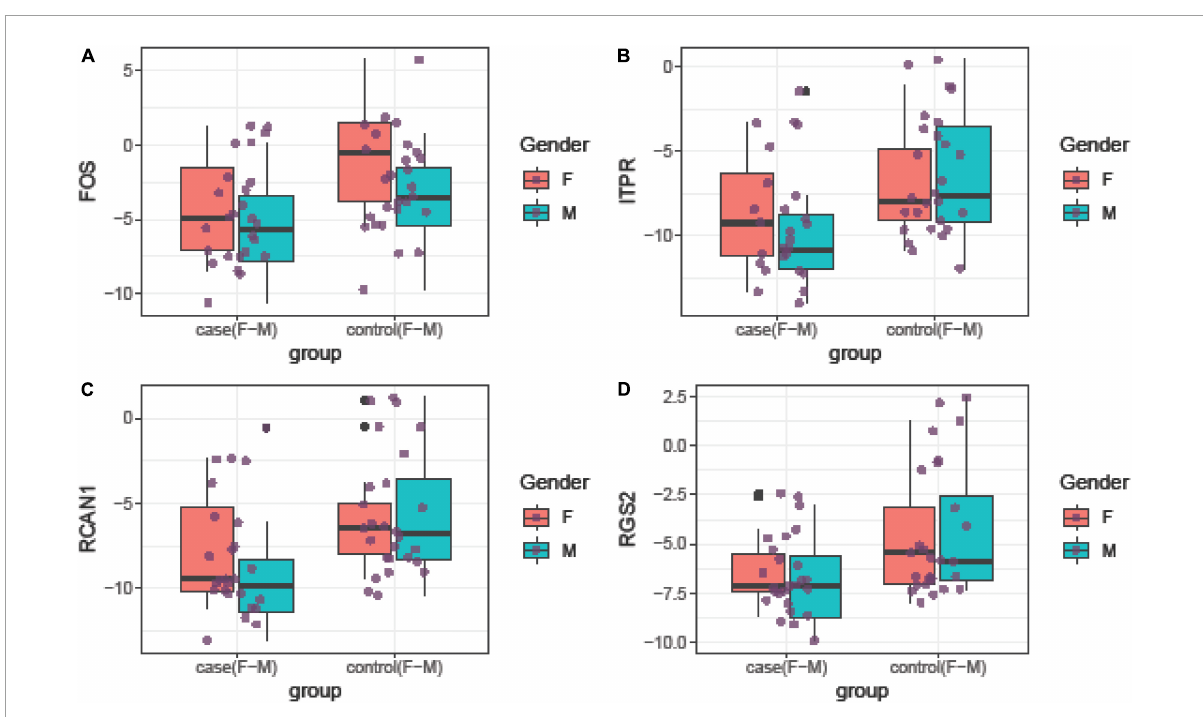
FIGURE1 Relative expression amounts of FOS (A) , ITPR (B) , RCAN1 (C) , and RGS2 (D) genes in affected tissues compared with control tissues.